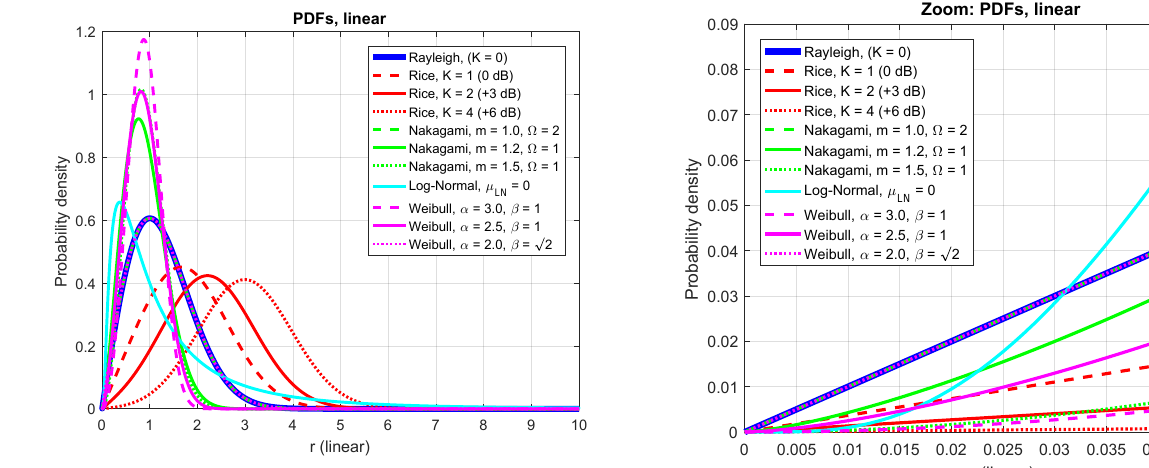
Figure 5. PDFs for Rayleigh, Rician, Nakagami and log-normal fading with different parameters. Where applicable, the parameter σ was chosen equal to unity.